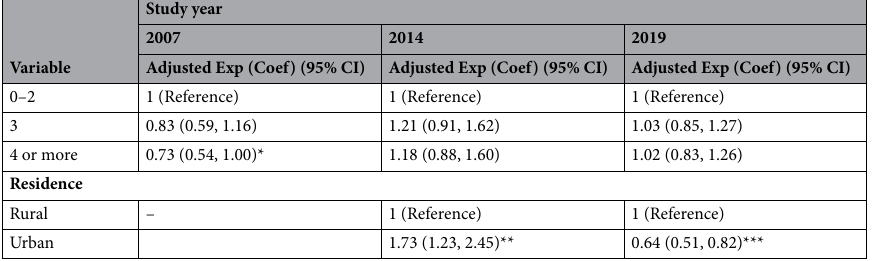
Table 6. Adjusted associations with ideal cardiovascular health metrics (0–14). Exp (Coef) = Exponentiated Coefficient CI = Confidence Intervals. * p < 0.05; ** p < 0.01; *** p <